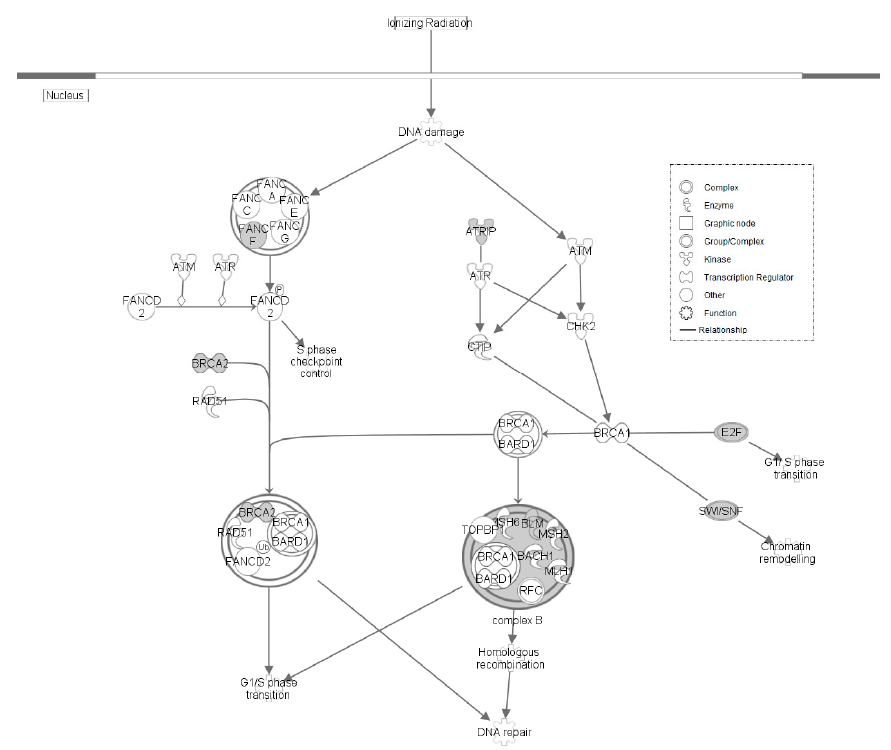
Figure 6. Role of BRCA in DNA Damage Response within LS line of Japanese quail. Molecular interaction and symbols are the same as described in Figure 3. Diseases and bio functions that were found to be significantly affected within the HS line ( p- value < 0.05) include cancers, neurological disease, organismal injury and abnor- malities, psychological disorders, and developmental disorders. In the LS line, the signif- icantly affected ( p- value < 0.05) diseases and biofunctions include cancers, and organismal injury and abnormalities, neurological disease, hematological disease, and metabolic dis- ease (Supplementary Material S9). The top physiological systems found to be significantly affected ( p- value < 0.05) in development and function within the HS line include embryonic development, nervous system development and function, organismal development, tissue development, and cardiovascular system development and function. The top significantly affected ( p- value < 0.05) systems within the LS line include nervous system development and function, tis- sue development, embryonic development, organismal development, and organ develop- ment (Supplementary Material S10). As the nervous system plays an integral role in stress response signaling, further analysis of its affected developmental functions was performed. The factors involved in nervous system development and functions were listed in Supplementary Materials S11 and S12. The top 10 functions and the related genes affected by SNPs in each line are listed in Supplementary Materials S13 and S14. Significantly affected ( p- value < 0.01) nervous system developmental functions in the HS line include branching, growth and outgrowth of neurites, neuritogenesis, dendritic growth and branching, proliferation of neuronal cells, polarization of hippocampal neurons, transport of synaptic vesicles, migration of